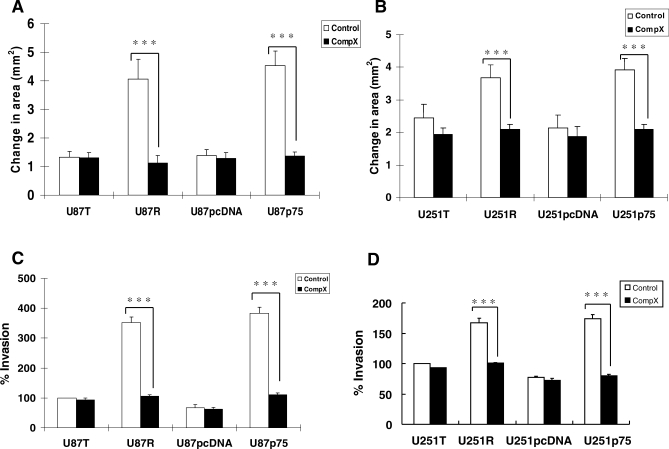
γ-Secretase Inhibitor Significantly Inhibited p75NTR-Induced Migration and Invasion in Glioma Cells(A and B) Monolayer circular migration assays of U87R and U251R cells, which endogenously express p75NTR, and U87p75 and U251p75 cells, which ectopically express p75NTR, were performed. Briefly, cells were seeded in monolayer wells through a cell sedimentation manifold. p75NTR-negative U87T, U87pcDNA, U251T, and U251pcDNA cells were used for comparison. Once the sedimentation manifolds were removed, cells were given complete medium containing 2 μM Compound X (CompX). Digital images of the cells were taken before migration at 0 h and then again at 72 h. Best-fit circles were drawn around the area covered by the cells at the 0 h and 72 h time points, and the actual cell area was determined using Axiovision 4.2 imaging software. Quantitative migration scores were calculated as the increase in the area covered by the cells beyond the initial area of the cells. γ-Secretase inhibitor Compound X significantly inhibited p75NTR-induced migration. Values shown are the mean ± s.e.m. from three independent experiments; triple asterisks (∗∗∗) indicate p < 0.001 as compared to control (one-way analysis of variance [ANOVA] with the Neuman-Keuls post-test).(C and D) 3D-collagen invasion assays of U87R, U87p75, U251R, and U251p75 cells were performed by mixing cells with 3D-collagen matrix (collagen, fibronectin, and laminin) and then seeding them into 8.0-μm pore size transwell chambers in the presence or absence of 2 μM Compound X for 6 h. Cells were fixed and stained, and invasive cells were counted. U87T, U87pcDNA, U251T, and U251pcDNA cells were used for comparison. Inhibition of γ-secretase by Compound X significantly inhibited p75NTR-induced glioma invasion. Values shown are the mean ± s.e.m. from three independent experiments; triple asterisks (***) indicate p < 0.001 as compared to control (one-way ANOVA with the Neuman-Keuls post-test).